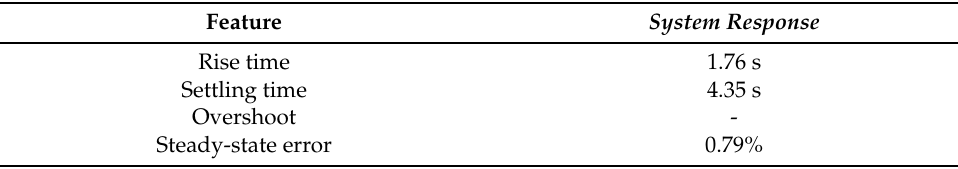
Figure 11. Scheme for carrying out tests and building the database. Table 2. Characteristics of the transient pressure